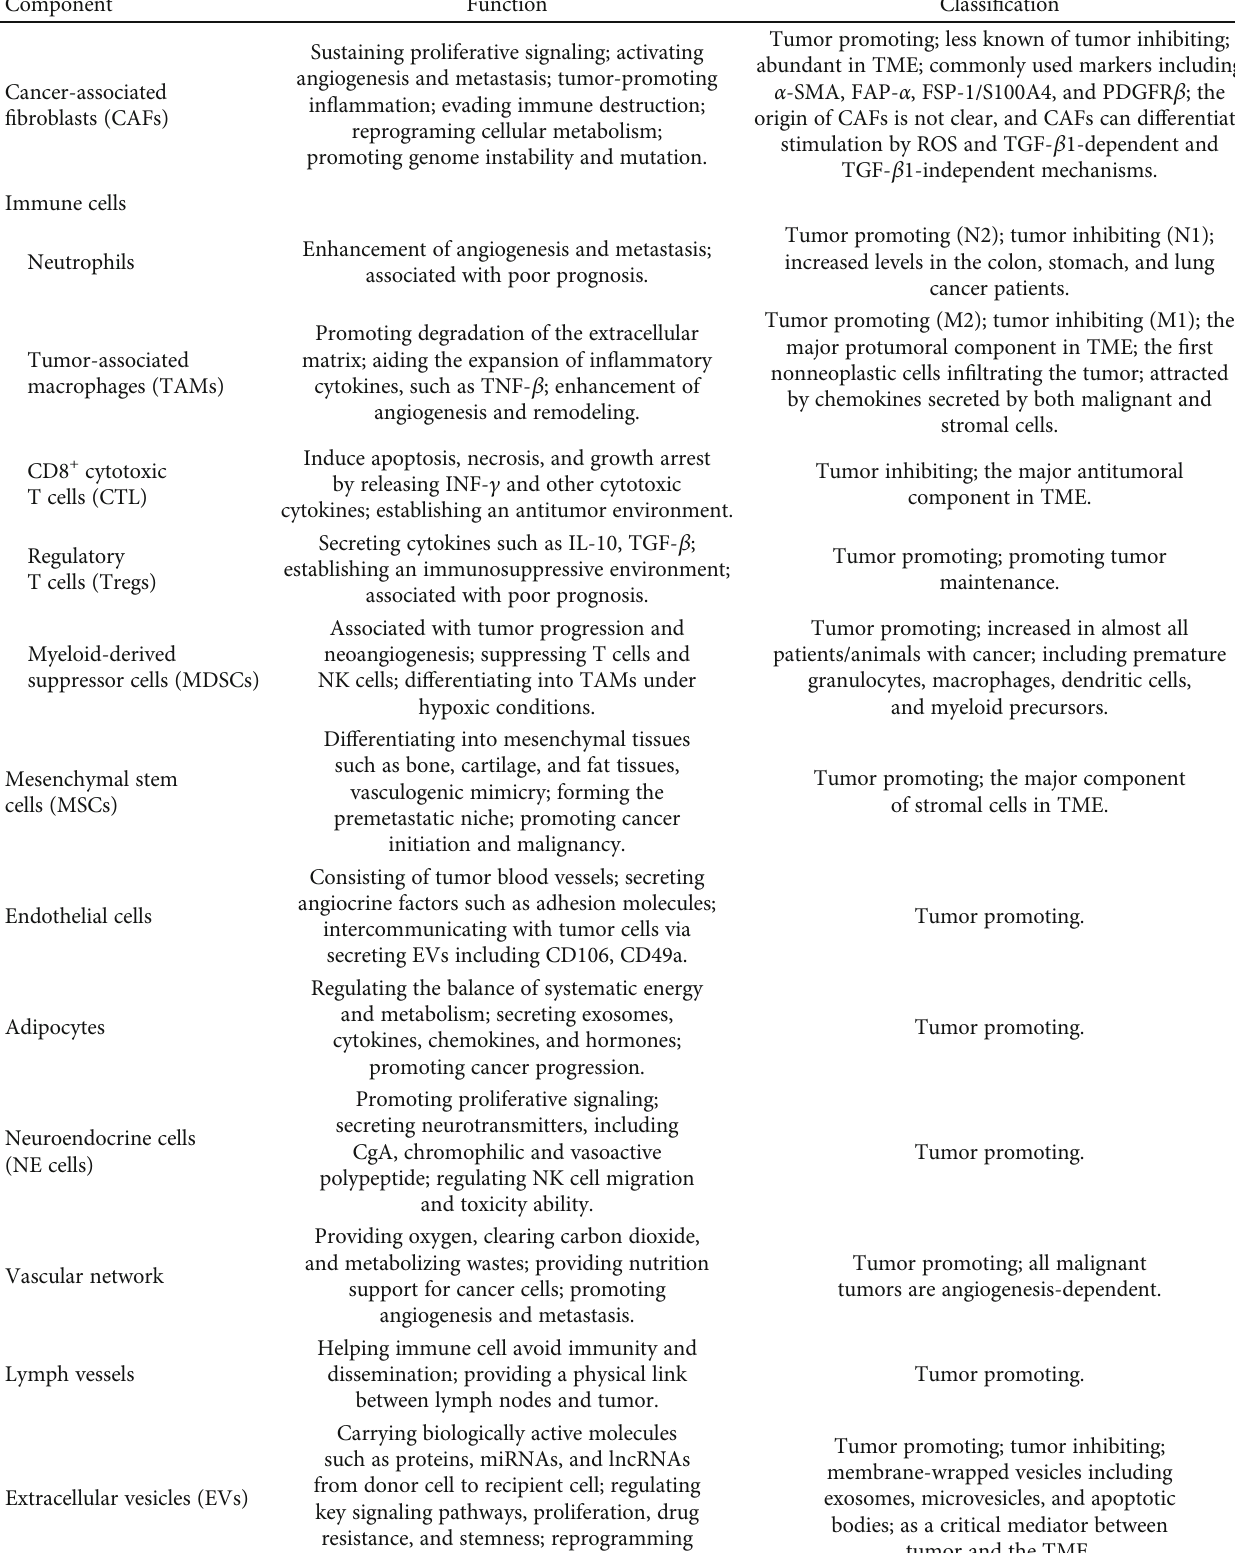
Table 1: Components, functions, and classi fi cations of